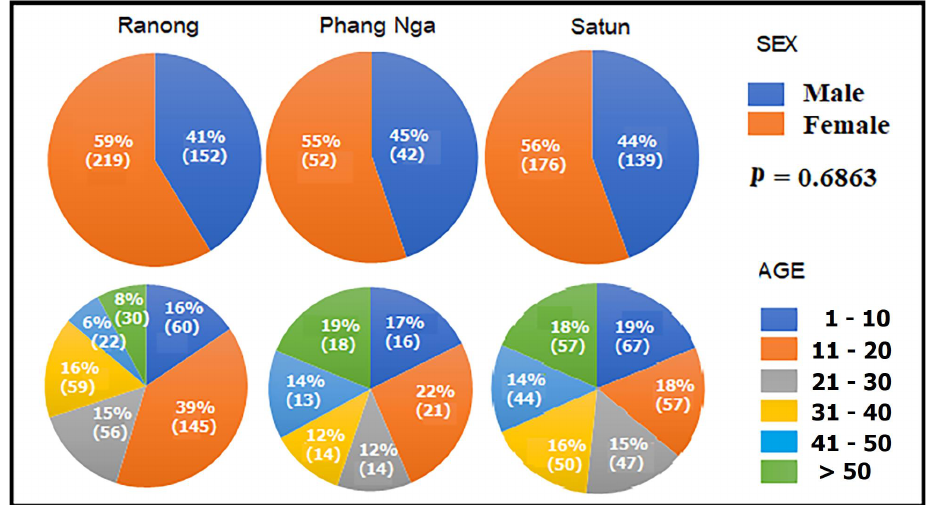
Figure 3. Pie graph reveals sex and age range of the study populations, i.e., the Moken from Ranong, the Moken from Phang Nga, and the Orang Laut from Satun provinces. Parentheses ( ) represent the number of participants.